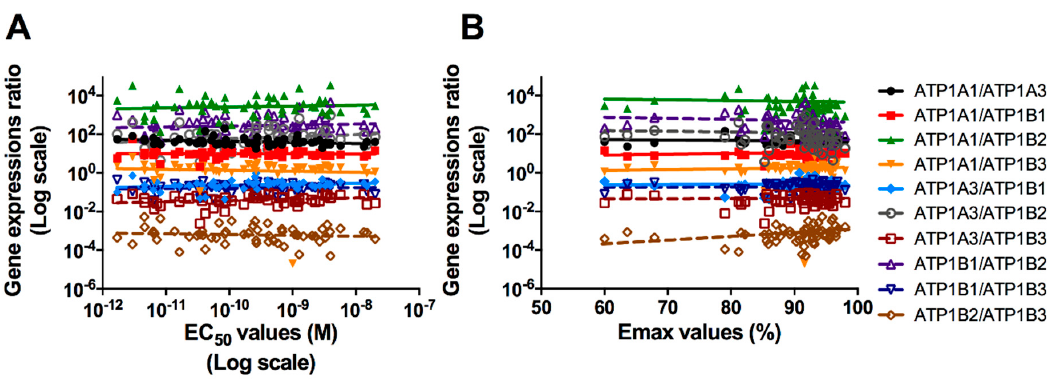
Figure 5. Dispersion graphs of the ratios of relative gene expressions of the different Na + /K + -ATPase subunits isoforms in function of the EC 50 ( A ) or the Emax ( B ) values, and relevant regression lines. Each point represents the mean EC 50 or Emax values recorded for each healthy volunteer.